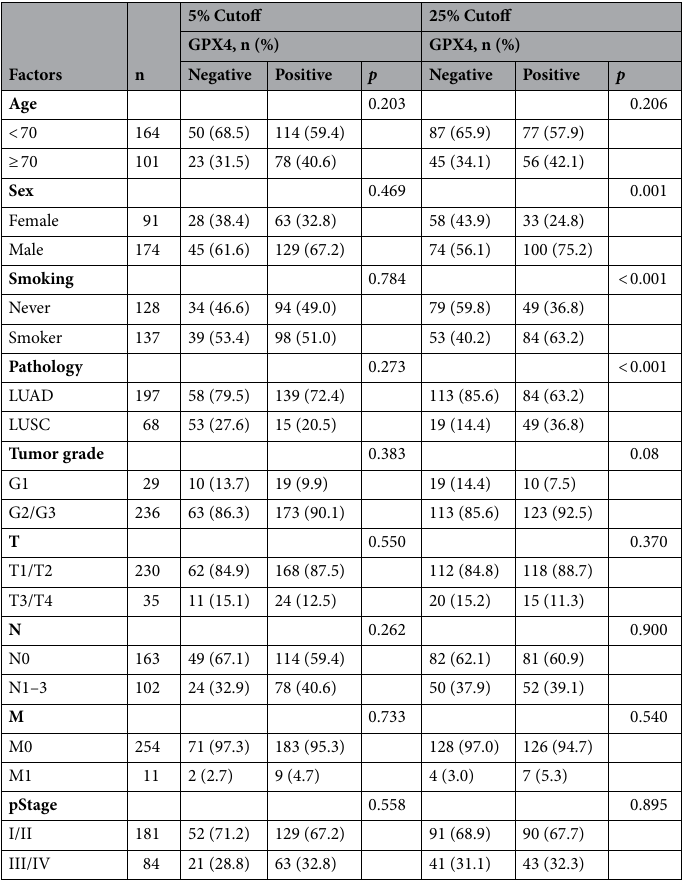
Table 2. Association between GPX4 expression and clinicopathological factors in all patients. GPX4 glutathione peroxidase 4, n number, T tumor, N nodes, M metastases, LUAD lung adenocarcinoma, LUSC lung squamous cell carcinoma, G1 well differentiated, G2 moderately differentiated, G3 poorly differentiated, pStage pathological